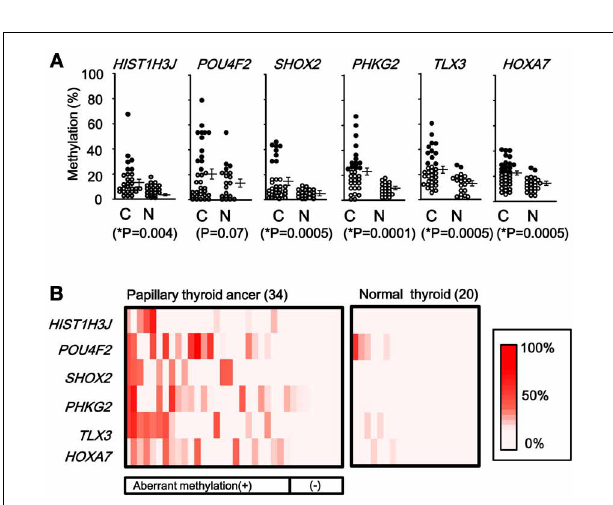
FIGURE 7 | Methylation status of the six genes in 54 samples analyzed by pyrosequencing. (A) Each gene was methylated to a different extent in each sample. C , 34 cancer samples. N , 20 normal samples. Circle , methylation ratio of each sample. Filled circles indicate that the gene is methylated with the methylation ratio > 25%. Bars , the mean and standard error of methylation ratios. P -values were calculated by t -test to compare distribution of methylation ratios between cancer ( C ) and normal ( N ) samples. Five genes ( HIST1H3J , SHOX2 , PHKG2 , TLX3 , and HOXA7 ) showed significantly higher methylation in cancer ( P < 0 . 05, t -test). POU4F2 tended to show higher methylation in cancer ( P = 0.07, t -test). (B) Heatmap for methylation status of the 54 analyzed samples. Among the 34 papillary thyroid cancer samples, 26 were aberrant methylation( + ) in at least one of six genes, while eight had no methylation. In Table 4 , the number of cancer samples with aberrant methylation ( n = 26) and the number of samples without aberrant methylation ( n = 8) refer to these